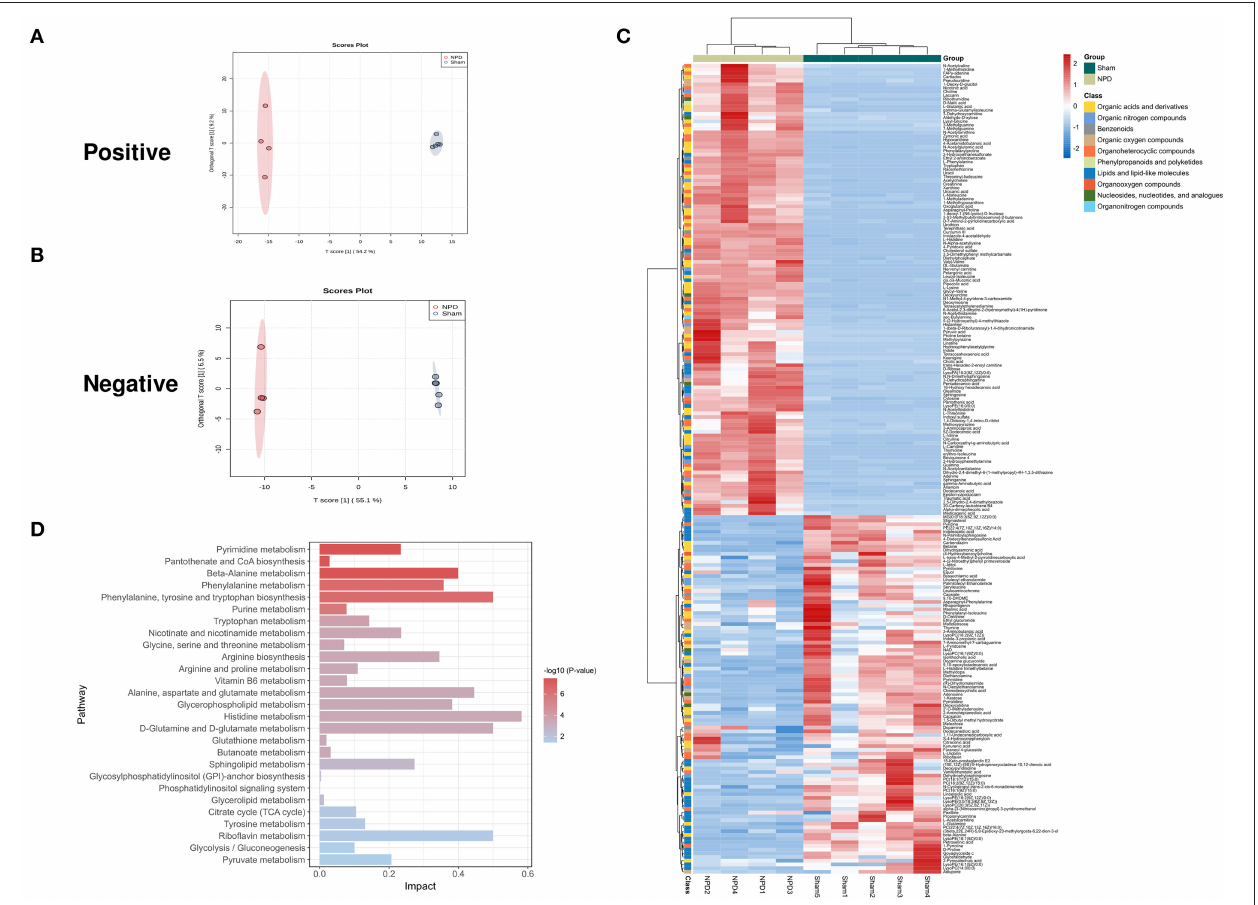
FIGURE 4 | Different expressed metabolites between NPD and sham. (A) OPLS-DA score chart of positive mode between sham and NPD. (B) OPLS-DA score chart of negative mode between sham and NPD. (C) Heatmap of 219 DEMs between sham and NPD after combing positive and negative modes. The classification of these DEMs is indicated by different colors. (D) Enriched KEGG pathways of DEMs between sham and NPD with p <